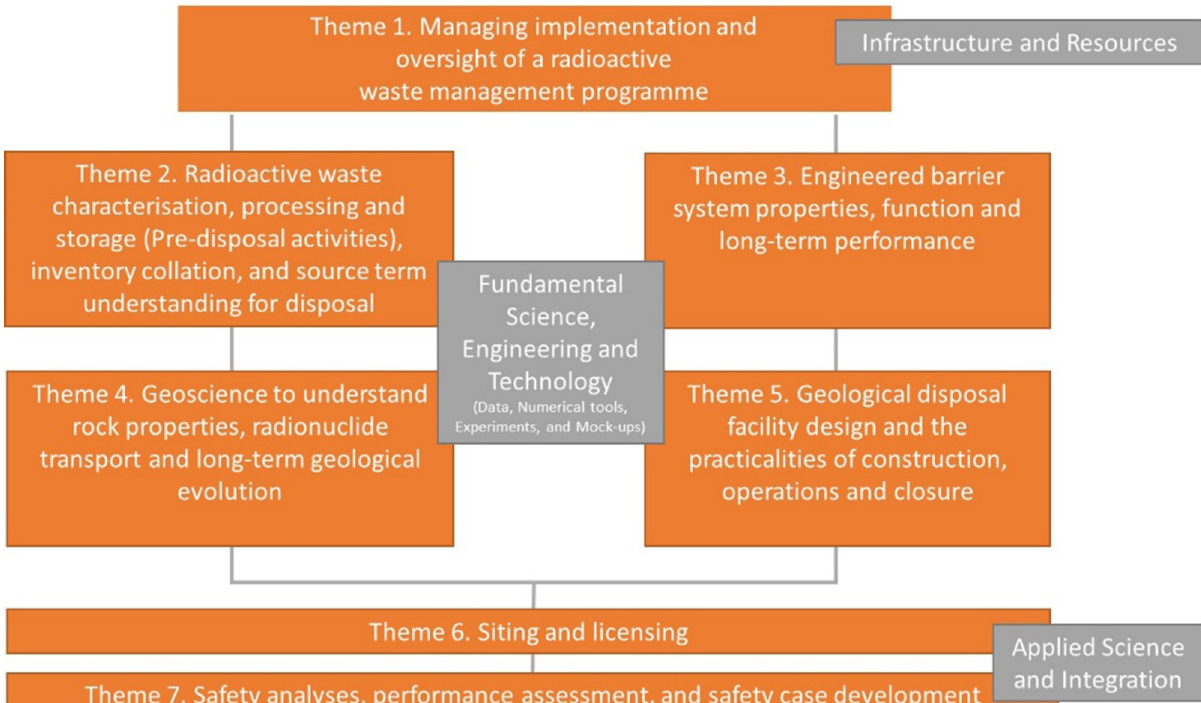
Fig. 2. Scienti fi c themes of the EURAD